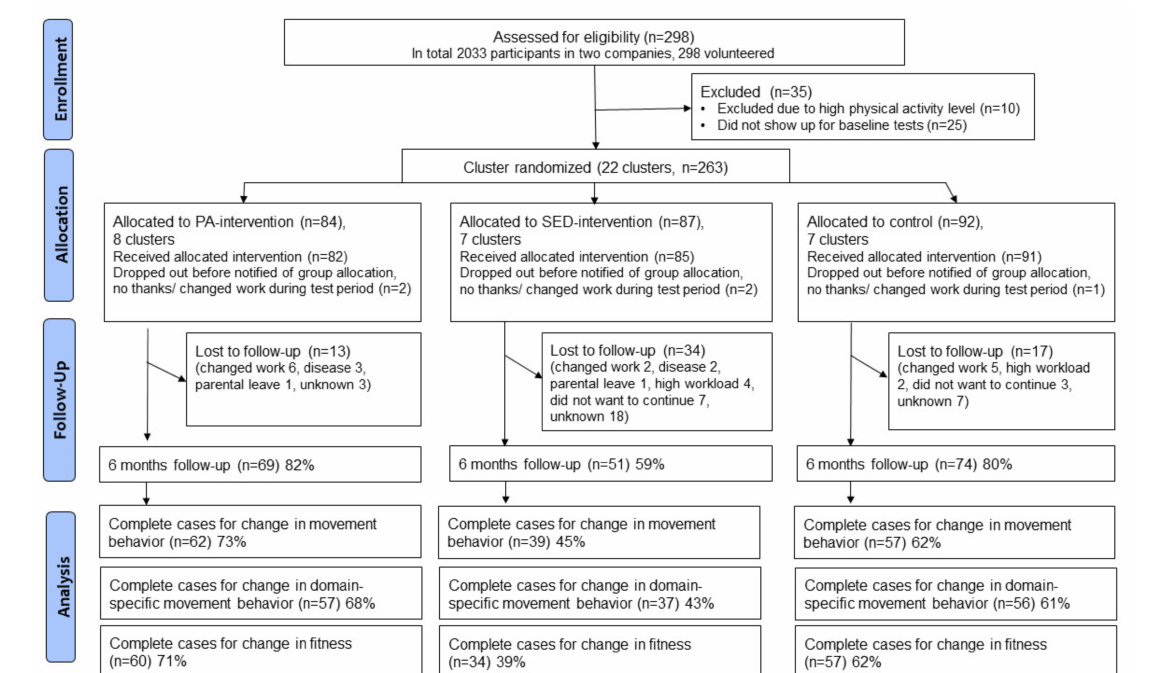
Figure 1. Flow diagram for enrollment, participation and